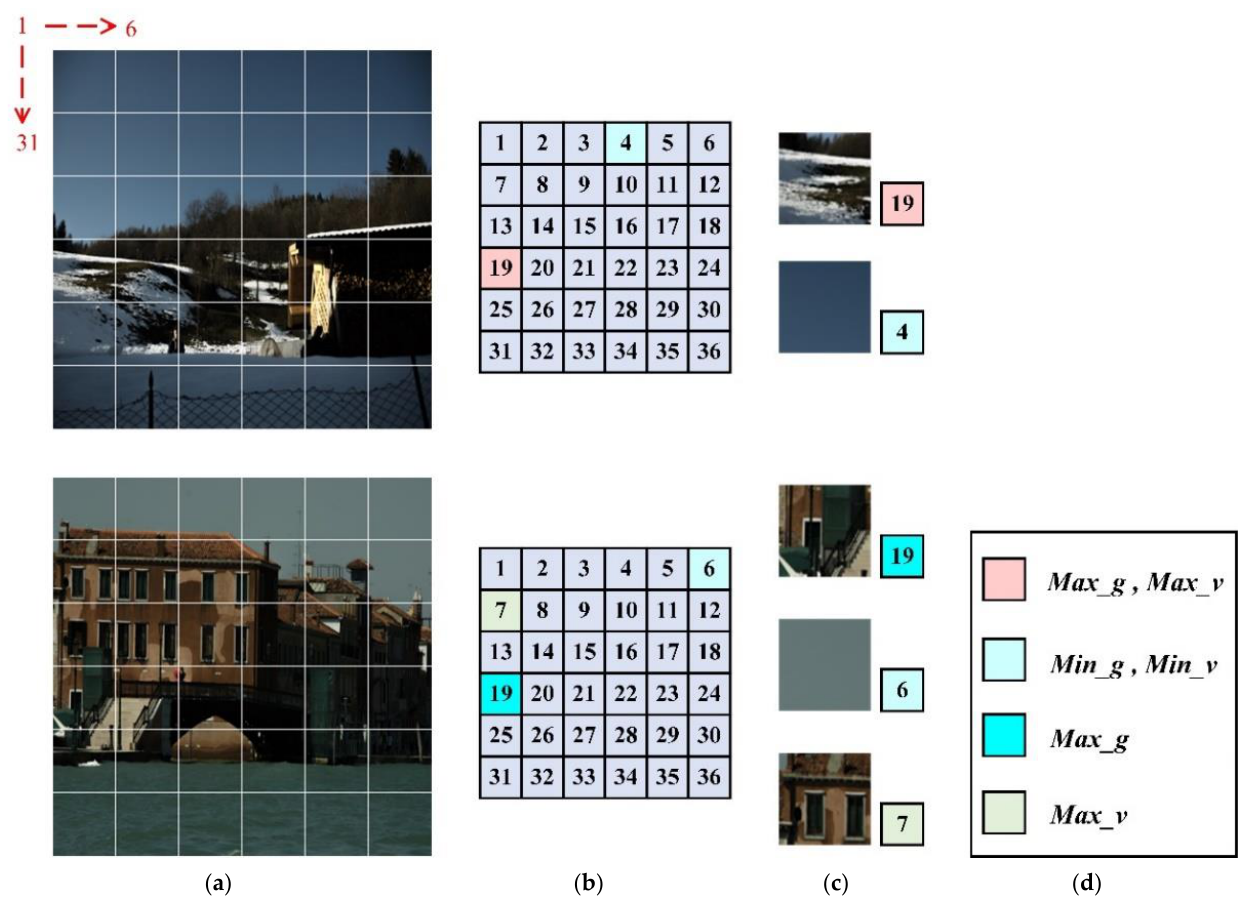
Figure 2. _ Min g , _ Max v , and _ Min v of an image. ( a ) Divided images. ( b ) Corresponding Figure 2. Min _ g , Max _ v , and Min _ v of an image. ( a ) Divided images. ( b ) Corresponding area label area label maps after image division. ( c ) Contents of some areas. ( d ) Figure legend. maps after image division. ( c ) Contents of some areas. ( d ) Figure